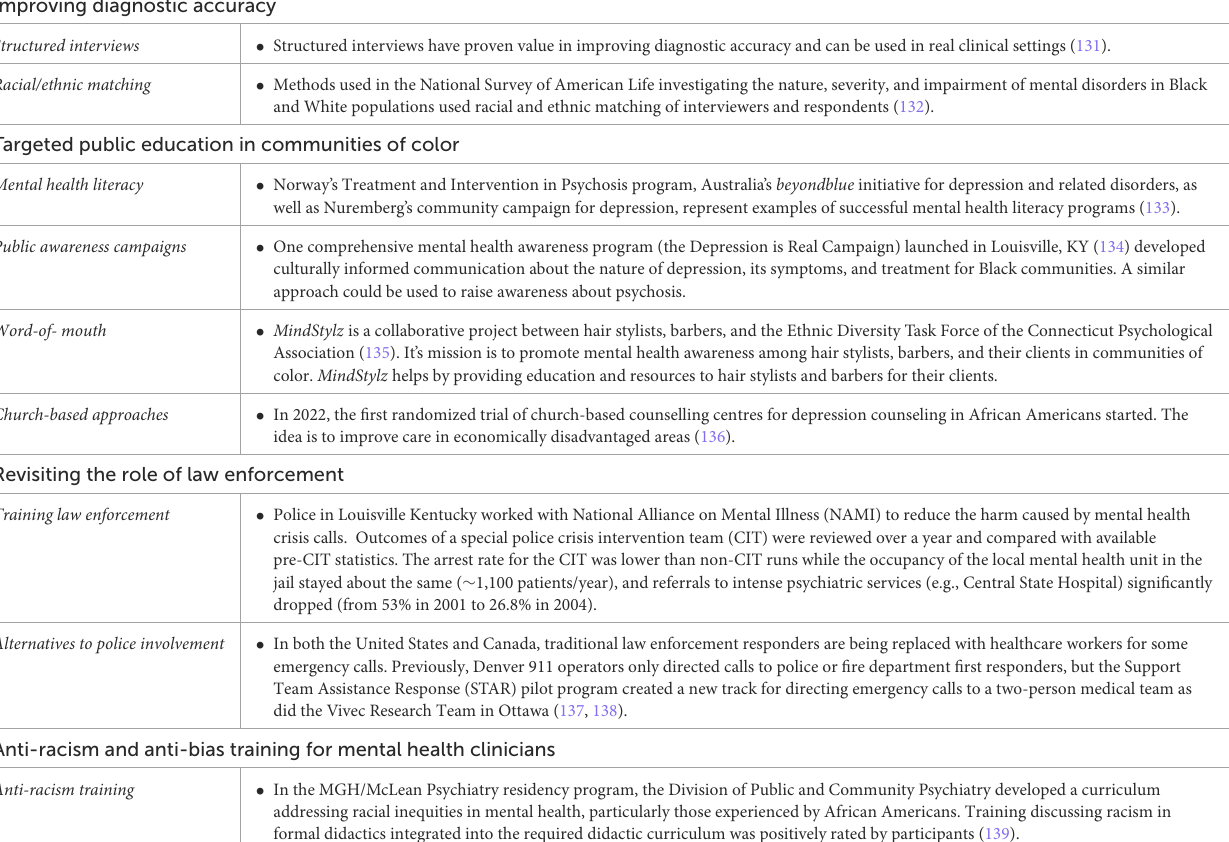
TABLE 5 Examples of how to reduce racial disparities in mental healthcare pathways for Black